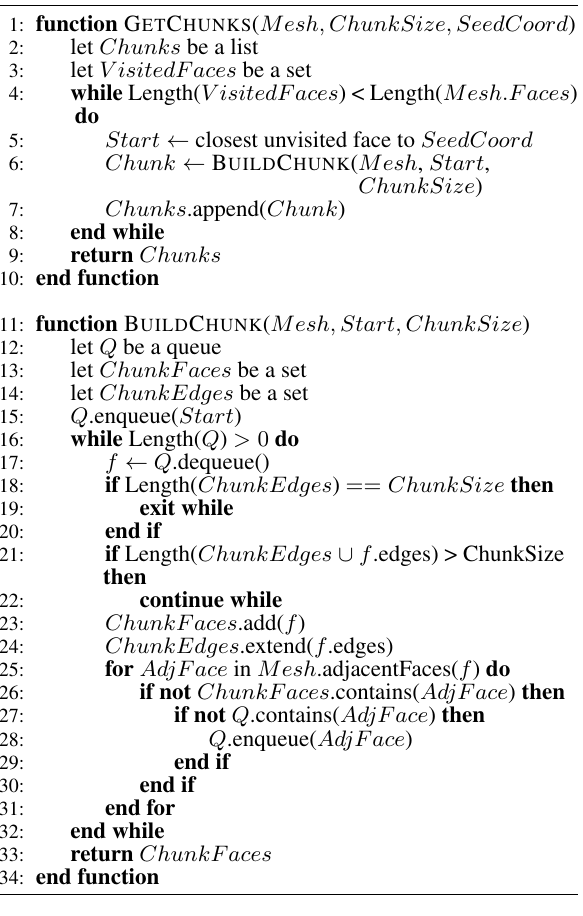
Algorithm 1 BFS mesh